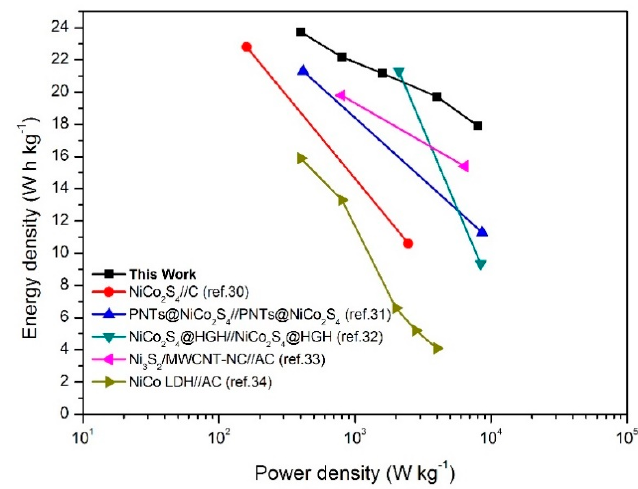
Figure 12. Ragone plots related to energy and power densities of NCS@NCOH//AC.